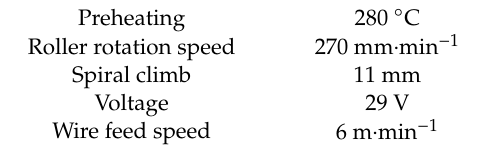
Table 4. Used cladding parameters.